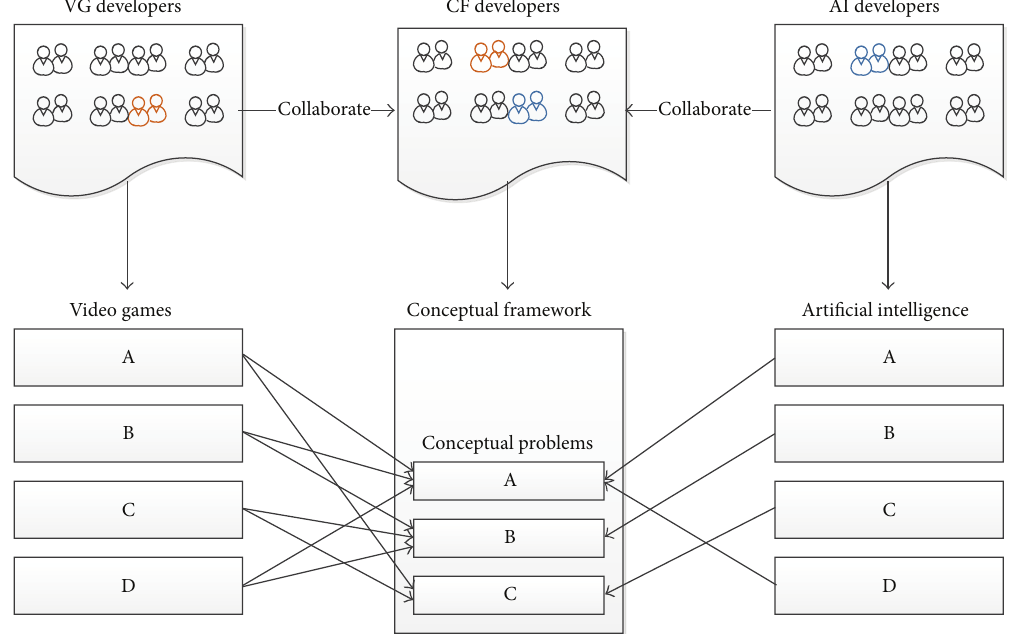
Figure 6: Collaboration between developers. Some game and AI developers, possibly large organizations or pioneers, also help developing the CF. Others only use it. Conceptual problems (CP) are listed and organized in the CF. A conceptual problem can be included in multiple games (CP B is included in VG B, C, and D) and can have multiple solutions (AI A and D are two different solutions for CP